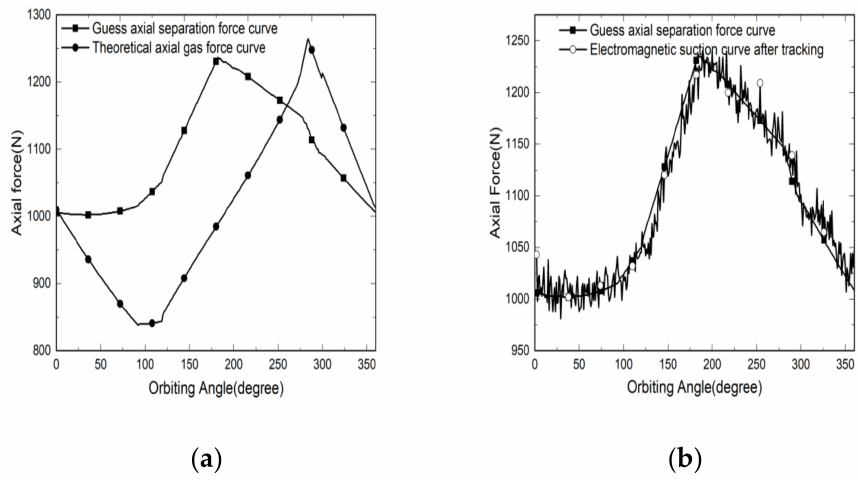
Figure 15. The experimental results obtained using the segmented probe tracking method: ( a ) initial diagram of non-segmented tracking; ( b ) segmented tracking results.